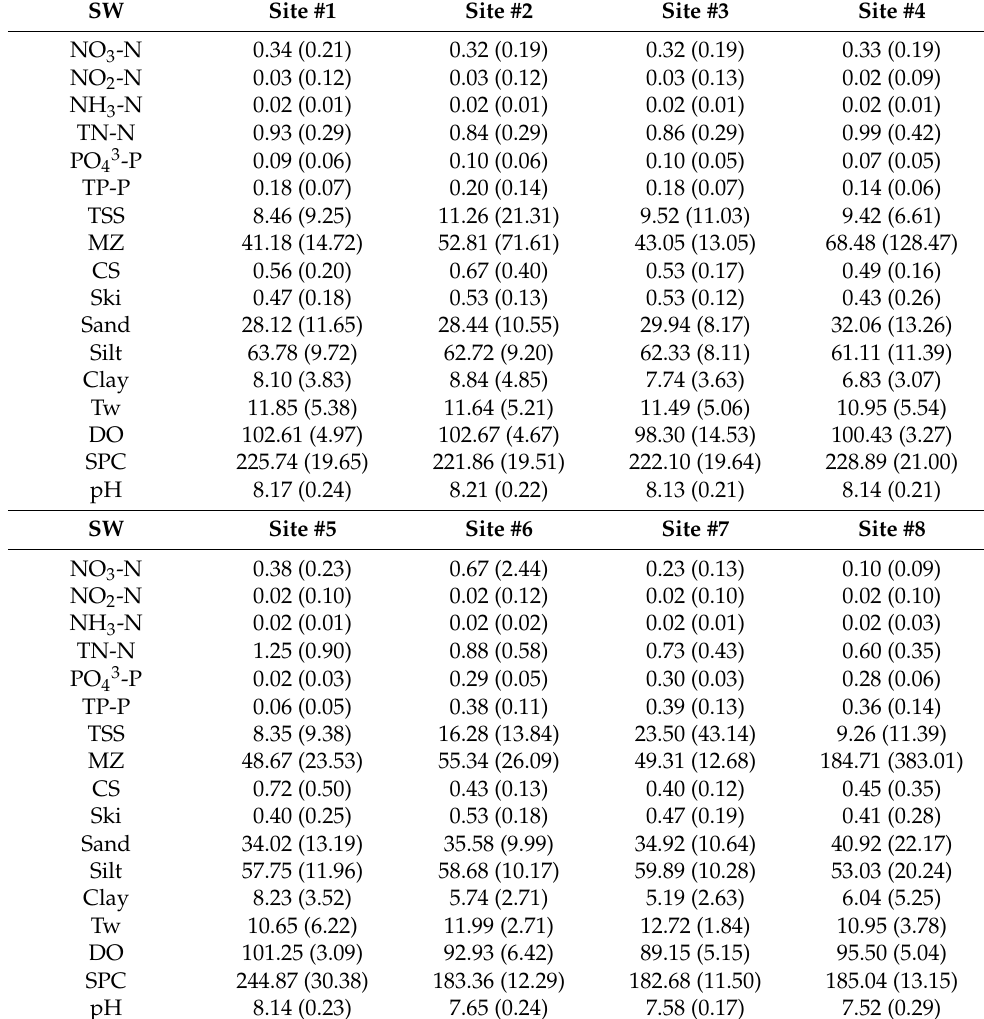
Table 2. Average values (with standard deviations in parentheses) for nutrient concentrations (mg L − 1 ), suspended sediment characteristics [total suspended solids; TSS (mg L − 1 ), mean particle size; MZ ( µ m), calculated surface area; CS (m 2 mL − 1 ), skewness; Ski, Sand (%), Silt (%), and Clay (%)], and physicochemical variables [water temperature (Tw; ◦ C), dissolved oxygen (DO;% saturation), specific conductance (SPC; µ s cm − 1 ), and pH] of surface water (SW) during the study period (January 2020–December 2021) for eight monitoring sites in Moore’s Run, Watershed, WV,